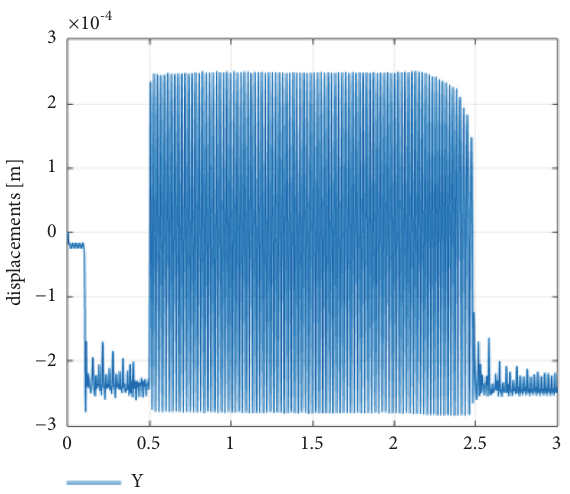
Figure 20: Predicted rotor vertical displacements during a radial landing test (DE node).